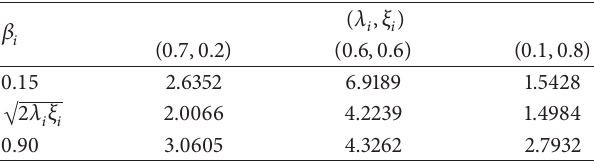
Table 1: Average cost 𝐽(𝑔) with different feedback gains and cost coupling strengths; Δ = 0.01 .